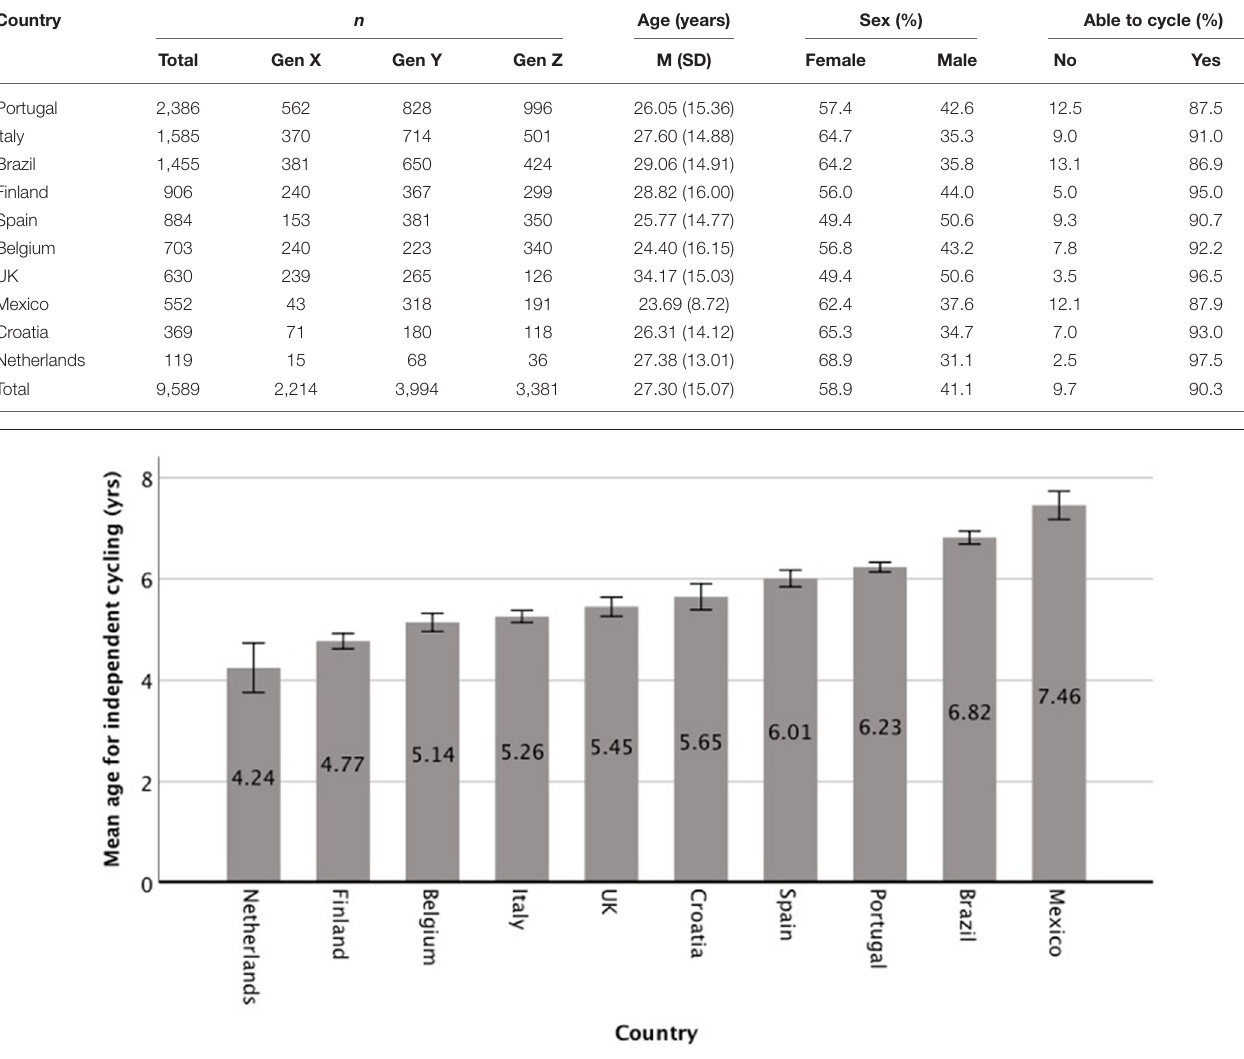
TABLE 1 | Sample distribution ( n ), means and standard deviations of age (years), sex distribution (%), and frequency of people who know how to ride a bicycle (%) in the sample of study. Country